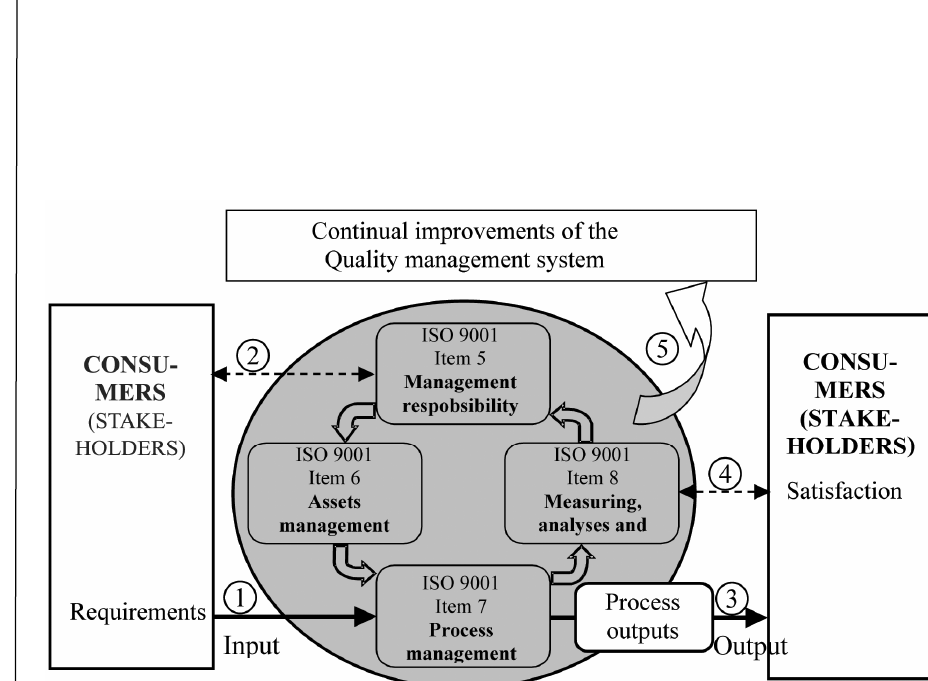
Figure 2 – Relations between the QMS subsystem and ISO 9001: 2008 standard Рис . 2 – Схема подсистем QMS и ISO 9001: